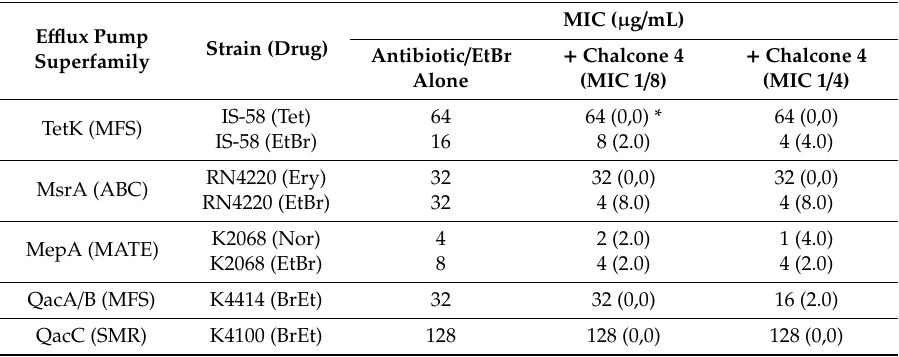
Table 4. Minimum Inhibitory Concentrations (MICs) for antibiotics and Ethidium Bromide (EtBr) in the presence or absence of chalcones isolated from Arrabidaea brachypoda flowers against di ff erent S.